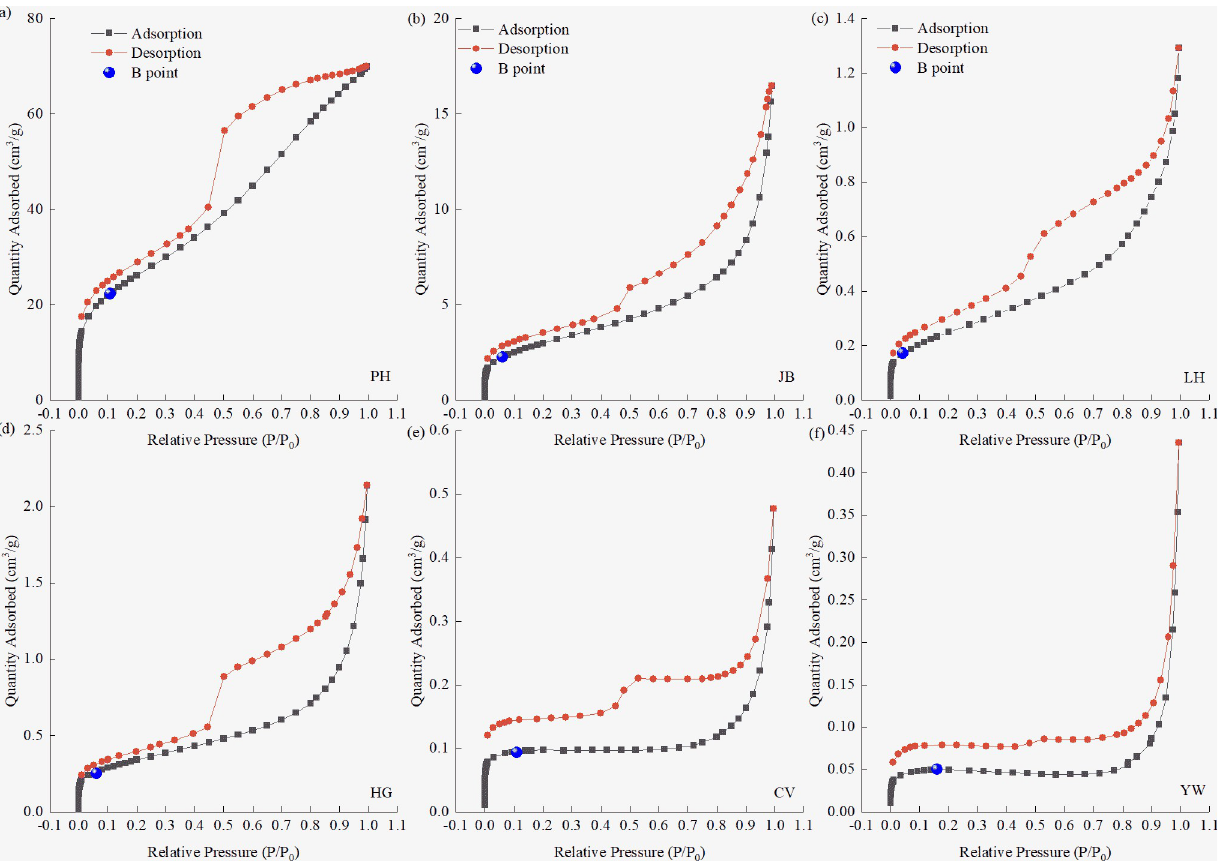
Fig 2. Adsorption/desorption isotherms of coal samples of different coal ranks. (a) PH Sample, (b) JB Sample, (c) LH Sample, (d) HG Sample, (e) CV Sample, (f) YW Sample.By analyzing the types of hysteresis loops of the six coal samples, the N 2 adsorption/desorption isotherm of the PH coal sample can be approximated to H2-type hysteresis loops, indicating that the coal samples may contain some ink bottle holes. The JB, LH, and HG coal samples belong to H3-type hysteresis loops, indicating that the coal samples are mainly composed of non-uniform slit holes formed by the accumulation of flake particles. The CV and YW coal samples belong to H4-type hysteresis loops, similar in shape to H3-type. However, samples showing H4-type typically contain uniform and narrow slit pores, indicating the presence of non-rigid aggregates of micropores and flaky particles in the coal sample. Except for the PH coal sample, the desorption branch of the other five coal samples suddenly dropped when P/P 0 = 0.42–0.5, approaching the adsorption branch; however, there was no closure point in the adsorption/desorption isotherm hysteresis loop. This phenomenon is typically due to solid swelling (intercalation phenomenon) [28] or due to the nature of the sample itself. The desorption branch deviations of the CV and YW coal samples were more evident than those of the other coal samples. This is attributed to the expansion of the interlayer distance due to adsorption. The interlayer distance is several times the molecular diameter, which is close to the micropore size, and the interlayer is then entered. The gas molecules are difficult to desorb; therefore, the isotherm does not close even under a very low relative pressure.